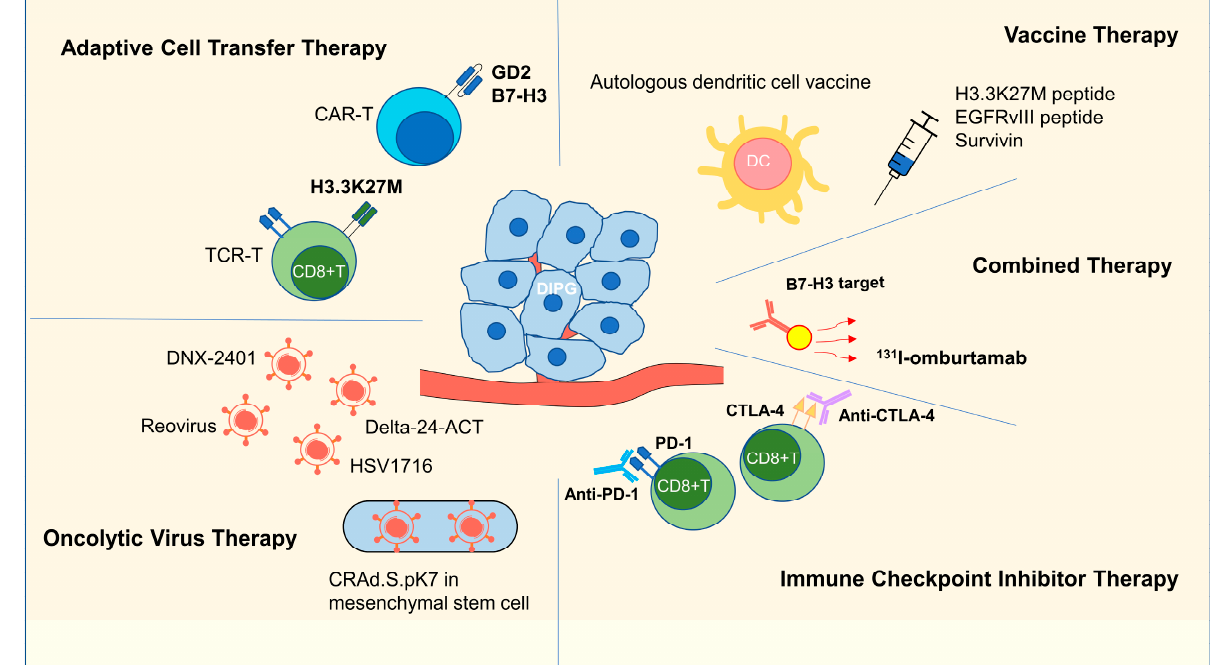
Figure 2. Immunotherapy strategies for DIPG. CAR T cells and TCR T cells are designed to target DIPG cells. Oncolytic viruses are designed to infect DIPG cells, kill them directly or attenuate their progression. A vaccine is injected to activate the adaptive immune system, especially CD8+ cytotoxic T cells. Anti-PD-1 and anti-CTLA-4 antibodies bind to PD-1 and CTLA-4, impeding the inactivation of CD8+ T cells, respectively. 131 I-omburtamab can kill DIPG cells by targeting B7-H3 and internal irradiation. CAR T, chimeric antigen receptor T cells; TCR T, T-cell receptor-gene engineered T cells; CTLA-4, cytotoxic T-lymphocyte-associated protein 4; PD-1, programmed cell death protein 1; DC, dendritic cell. Table 1. The clinical trials of immunotherapies for DIPG.